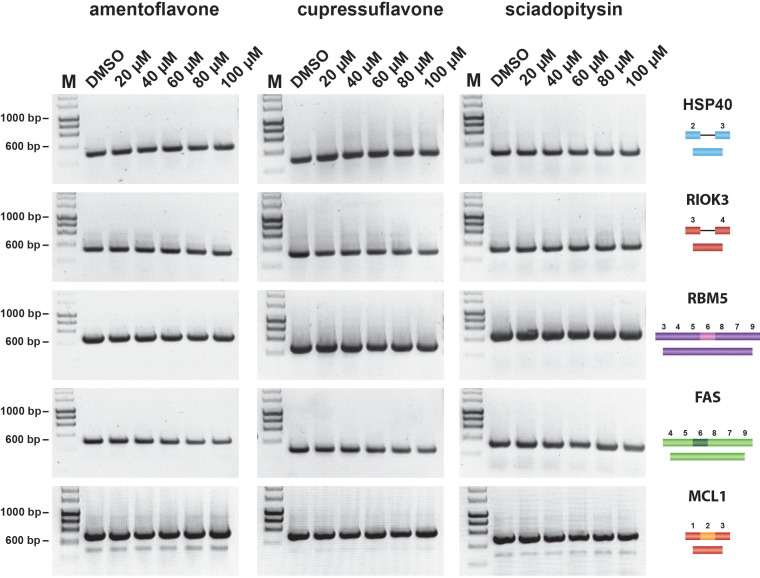
Amentoflavone, Cupressoflavone and Sciadopitysin do not alter pre-mRNA splicing in cellulo.HEK293 cells were treated with either DMSO (control), or with 20 µM, 40 µM, 60 µM, 80 µM, or 100 µM of either amentoflavone, cupressoflavone, or sciadopitysin, for 24 hr. Using RT-PCR and primer pairs to detect changes in exon skipping of RBM5, FAS and MCL1 pre-mRNAs, as well as intron inclusion in HSP40 and RIOK3 pre-mRNAs, no alteration of pre-mRNA splicing for these transcripts were detected in the presence of these bioflavonoids. The positions of different cDNA products are pictured on the right of the gel images and the molecular weight markers are shown on the left. Lane M, marker (hyperladder, 1 kb).